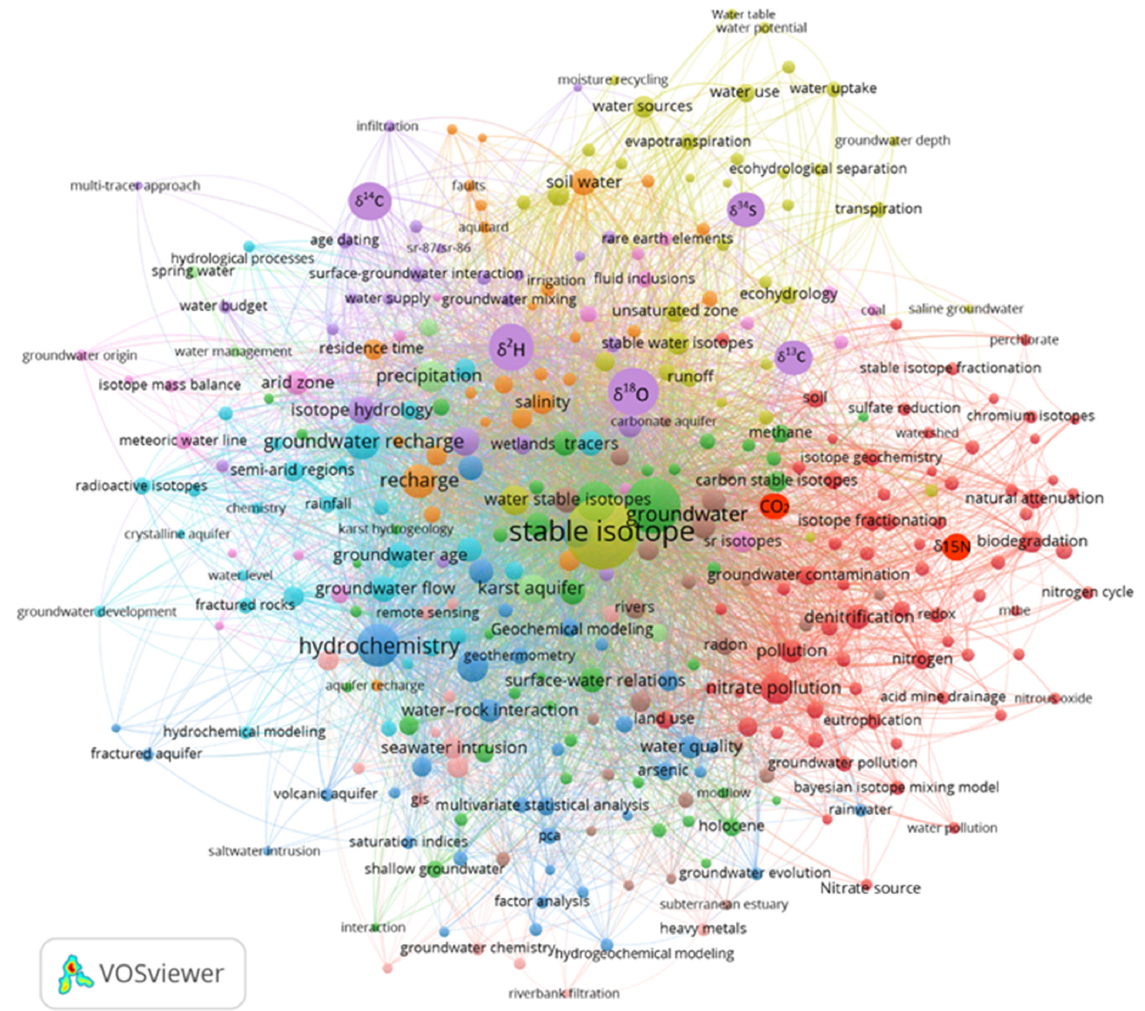
Figure 6. Co-occurrence of author keywords map in both databases (WoS y Scopus) . Table 4 summarizes the literature review conducted on the most relevant clusters (clusters from one to six with occurrence greater than 240) shown in Figure 6. This table includes the main topics emerging from each cluster. Table 4 Keywords clusters about GSI.